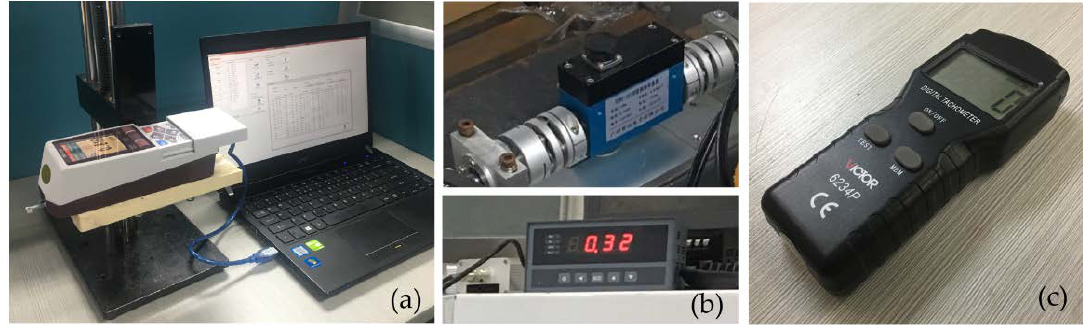
Figure 3. Equipment used in experiments: ( a ) surface roughness tester (Mitutoyo, SJ-210); ( b ) torque sensor (Forsentek, FY02); ( c ) tachometer.